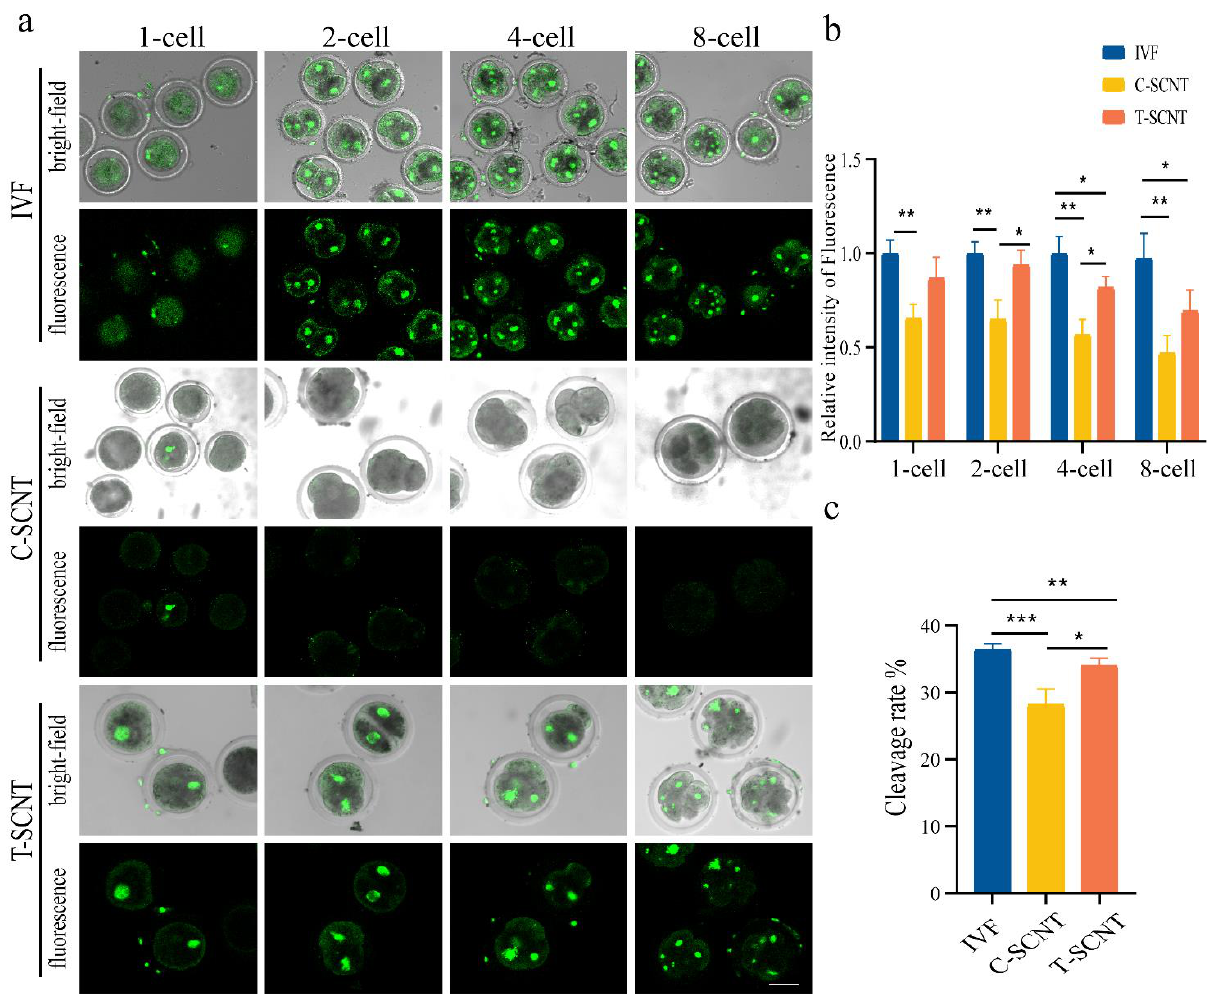
Figure 7. Effect of treatment of donor cells (EFCs) with NaCr on the level of H3K18cr and develop- mental competence in SCNT embryos. ( a , b ) Fluorescence staining pattern and relative fluorescence intensity of H3K18cr in IVF and EFC SCNT embryos (C-SCNT and T-SCNT) at different stages (scale bar, 50 µm). ( c ) The cleavage ratios of embryos at all cleavage stages in IVF, C-SCNT, and T-SCNT. The number of embryos was 40 ± 5 in the IVF, C-SCNT, and T-SCNT groups. C-SCNT (control SCNT) and T-SCNT (experimental SCNT) groups represent cloned embryos generated with un- treated and NaCr-treated donor cells (FFCs), respectively. The IVF group represents a blank control group; * p < 0.05, ** p < 0.01, *** p < 0.001; no asterisk indicates no significant difference.